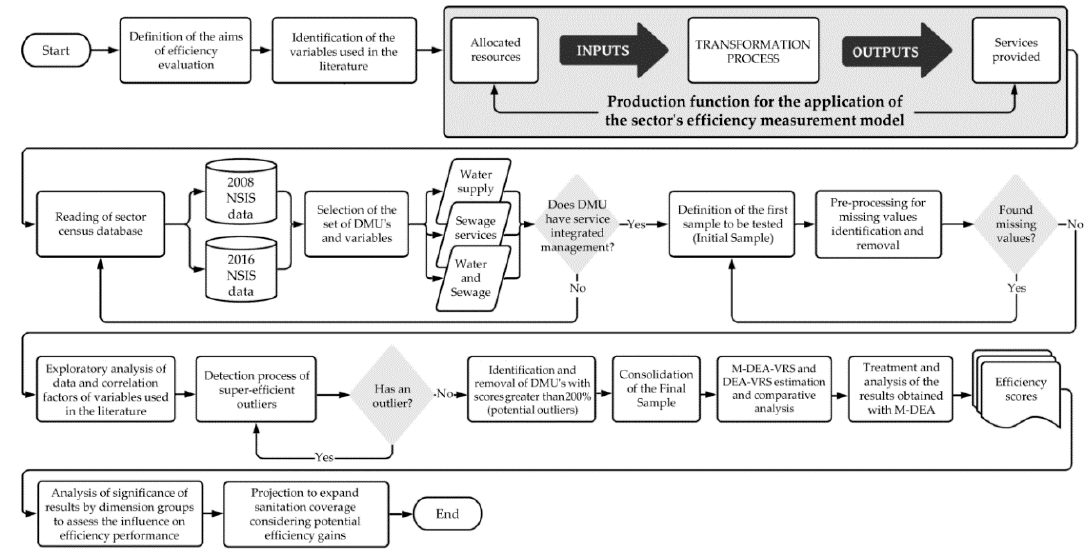
Figure 1. Flowchart of the approach adopted in applying the M-DEA. Source: Author’s own elaboration based on Golany and Roll [40] and Slack et al. [41].